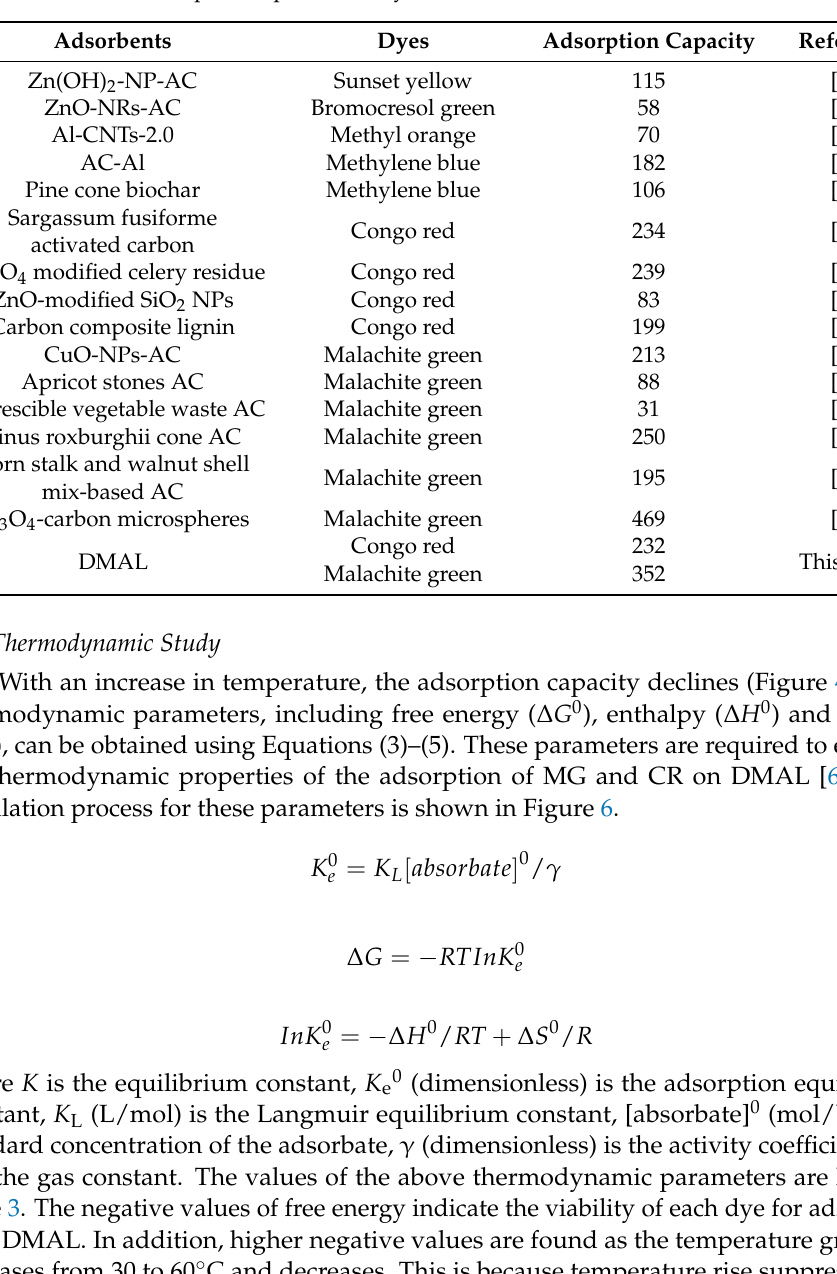
Table 2. Maximum adsorption capacities of dyes onto DMAL different